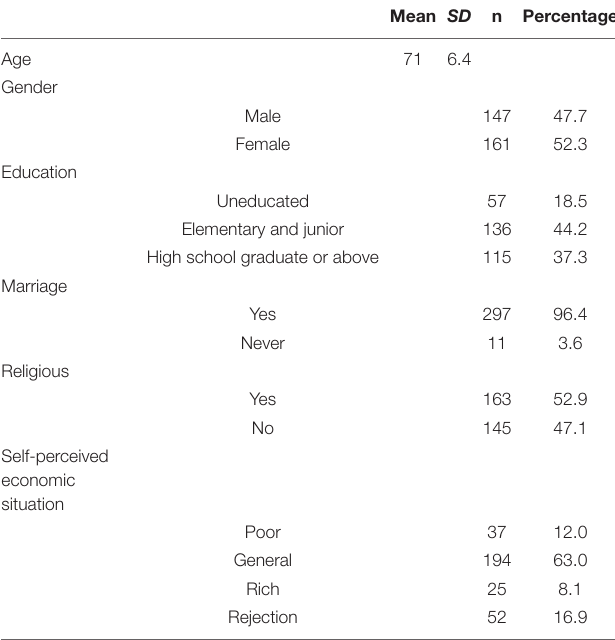
TABLE 1 | Participant socio-demographic characteristics ( N =